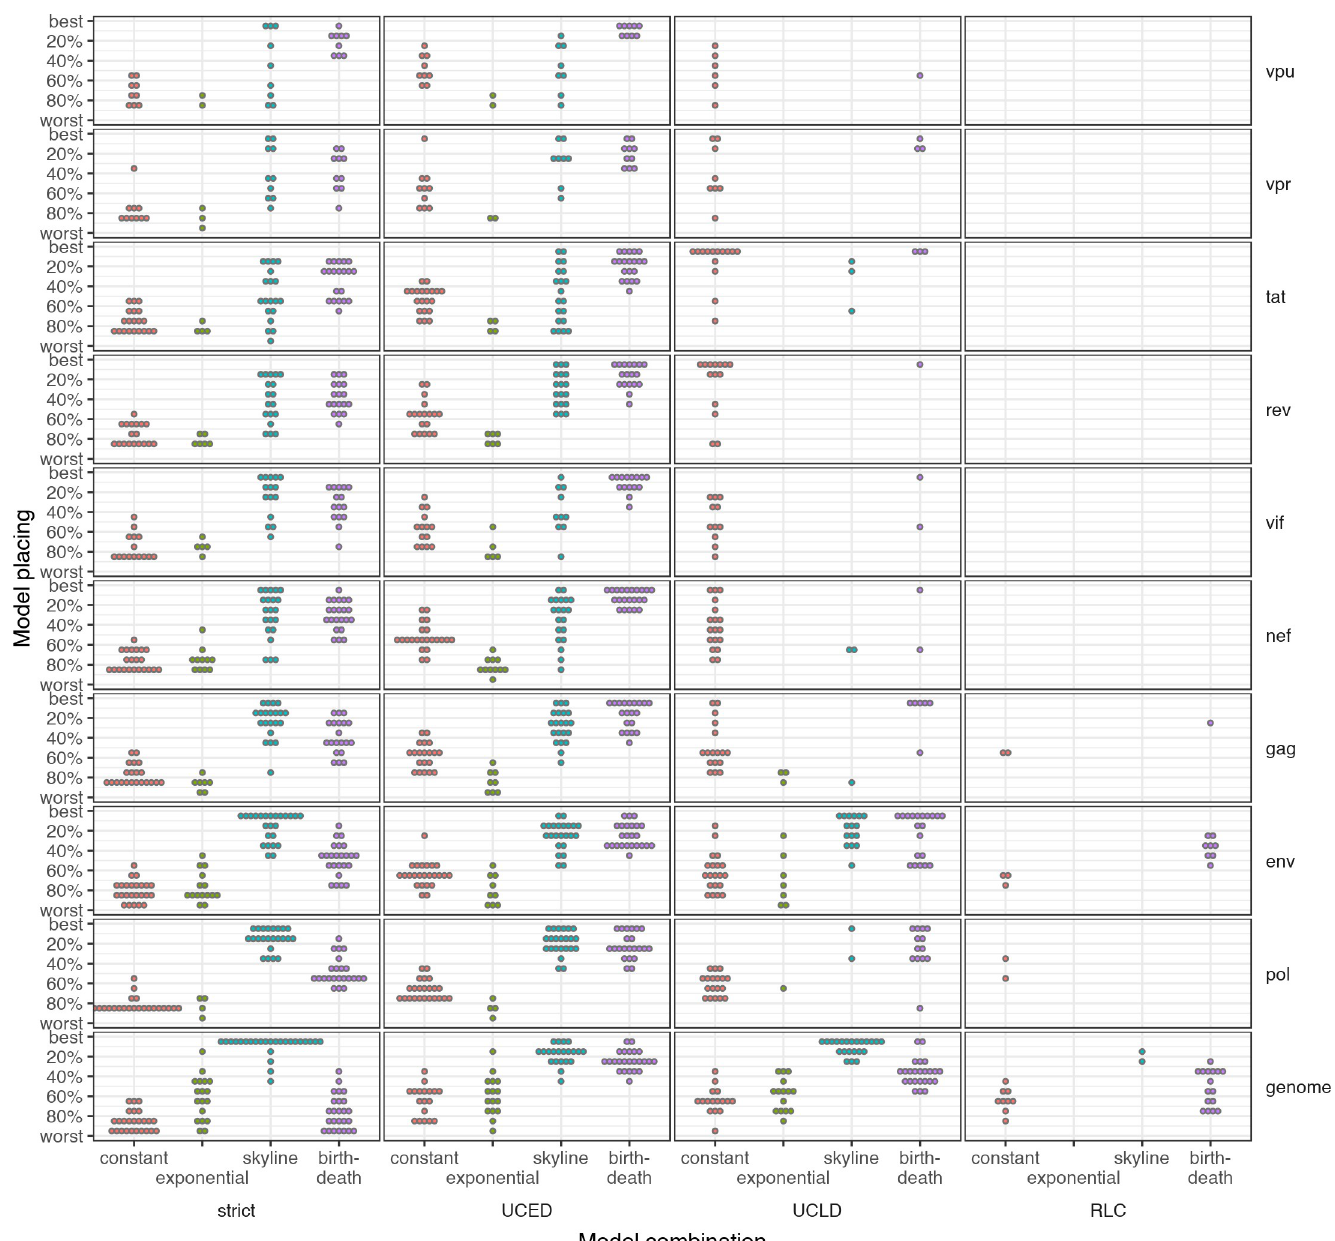
Fig 5. Comparison of model rankings for each model combination for single founders for each gene and NFL genome. Each combination of the four clock (strict, uncorrelated exponential (UCED) relaxed, uncorrelated lognormal relaxed (UCLD), and random local (RLC)) and four population models (constant, exponential, skyline and birth-death) are represented on the x-axis, and the model placing on the y-axis. Each dot represents the model fitted for one participant. Models were ranked by their estimated marginal likelihood and rankings scaled by the total number of models fitted for that participant and gene.